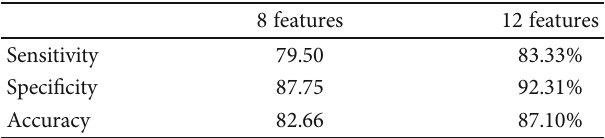
Table 19: Results of Random Forest.